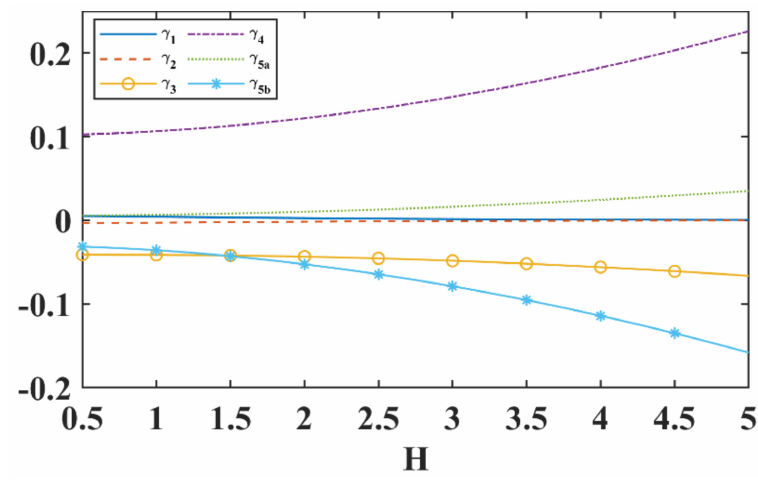
Figure 2. Variation of the interaction coefficients with the channel depth